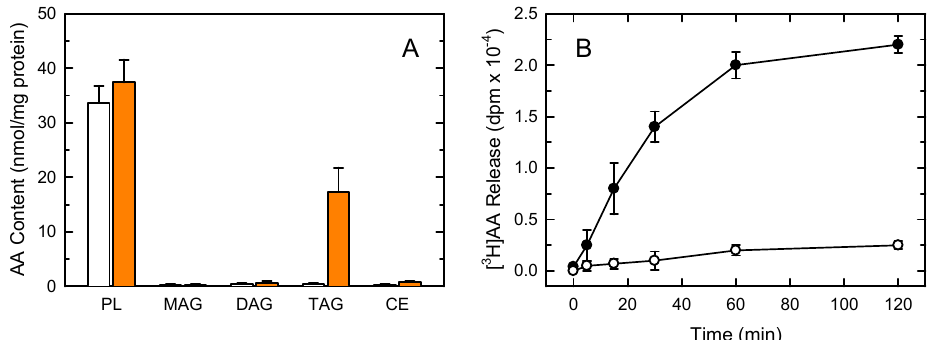
Figure 1. AA distribution in murine macrophages. ( A ) AA incorporation into the lipids of mouse peritoneal macrophages. The cells were either untreated (open bars) or treated with 20 µM AA (orange bars). Afterward, the various lipid classes were isolated and their AA content was measured by GC-MS. ( B ) The cells, prelabeled with [ 3 H]AA, were either untreated (open symbols) or treated with 0.5 mg/mL zymosan (black symbols) for the times indicated. Afterward, the extracellular media were removed and analyzed for 3 H-radioactivity content. The data are expressed as mean values ± S.E.M. ( n = 6).